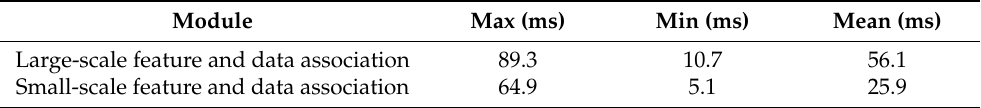
Table 2. Runtime of the two main